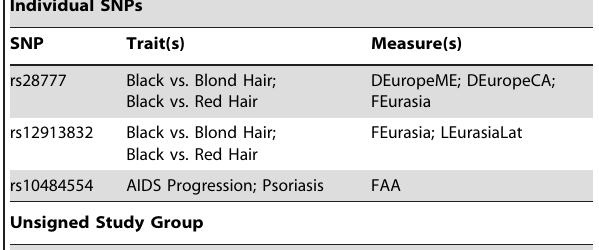
Table 4. Individual SNPs and study groups that were significant for at least one Delta, F st , LLC, or iHS measure in the II individual SNP, group unsigned, or group signed